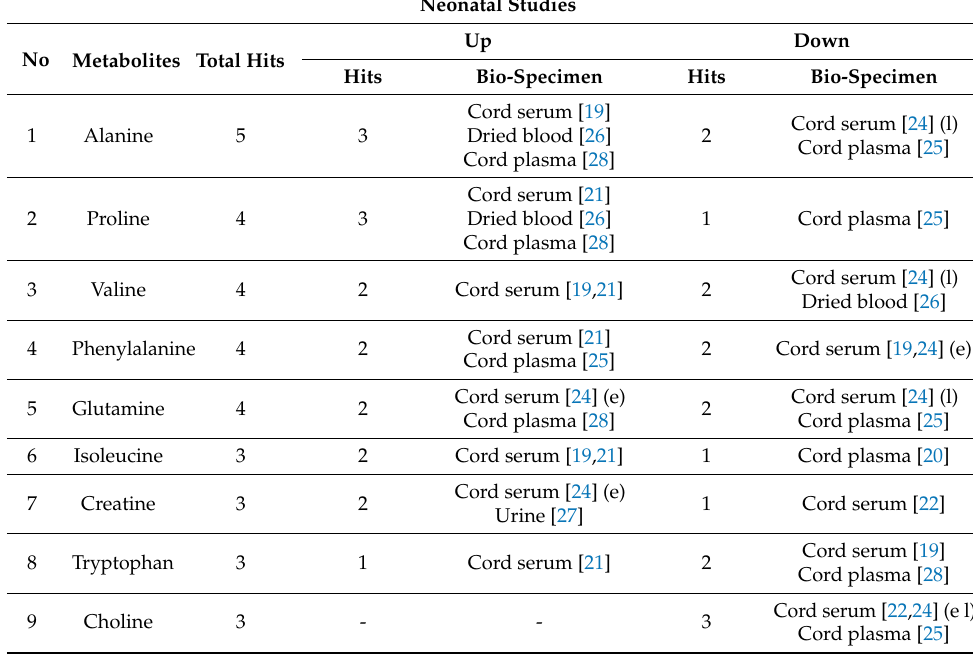
Table 2. High Frequency Metabolic Biomarkers of Human Neonatal Studies and Maternal